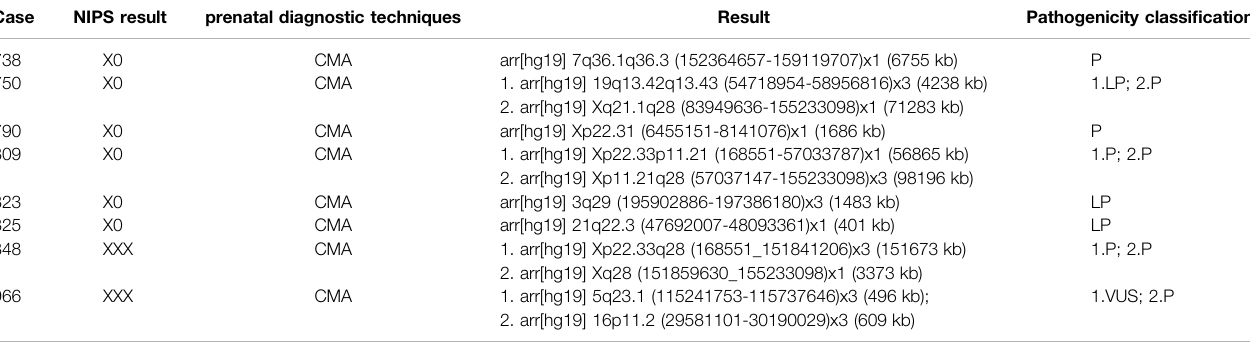
TABLE 5 | Likely pathogenic and pathogenic CNVs by CNV detection techniques in 8 cases with positive NIPS for SCA.